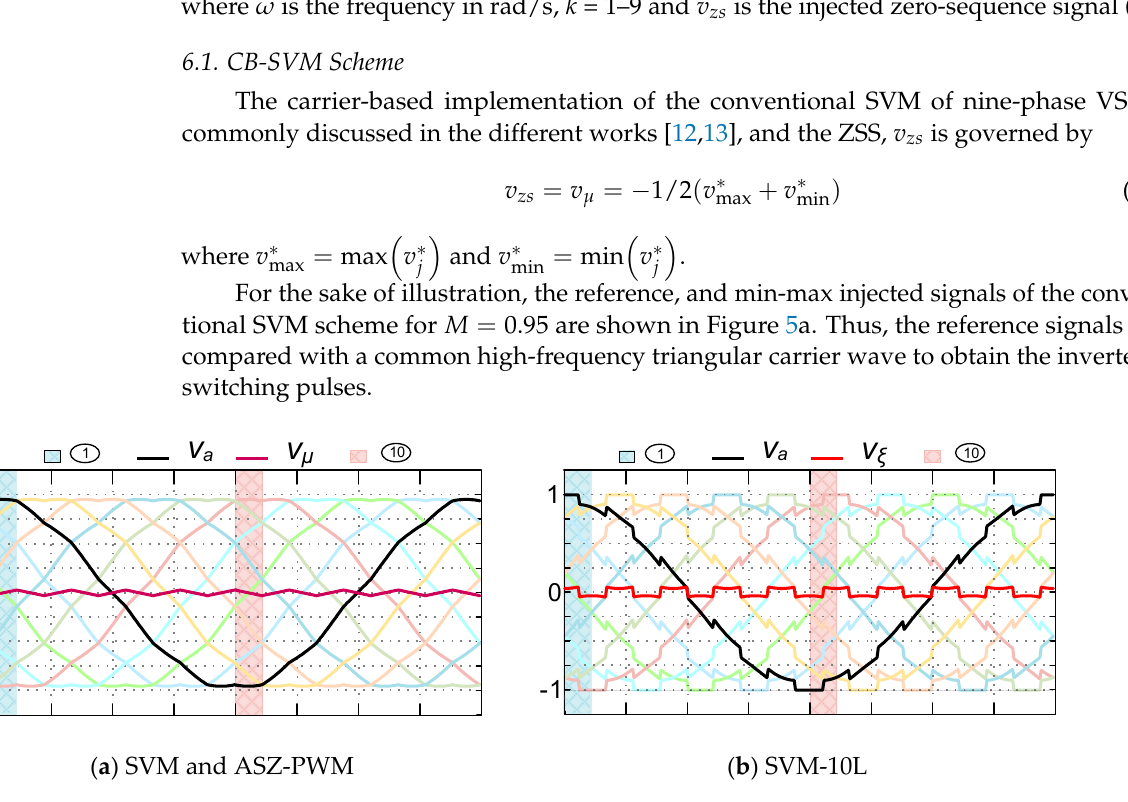
Table 6. Selection of Carrier Waves for The CBPWM of the Analyzed PWM Schemes. Sector